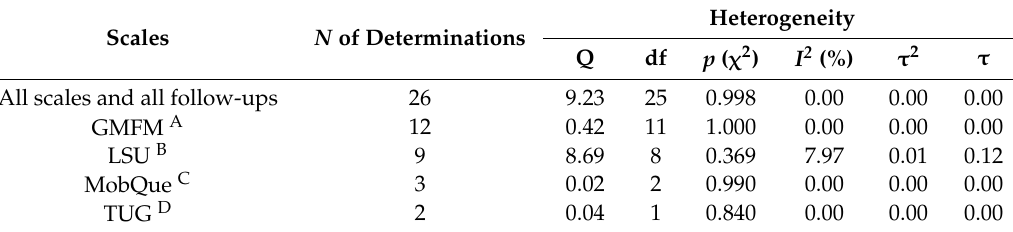
Table 5. Global heterogeneity in the control group: all scales and follow-ups.